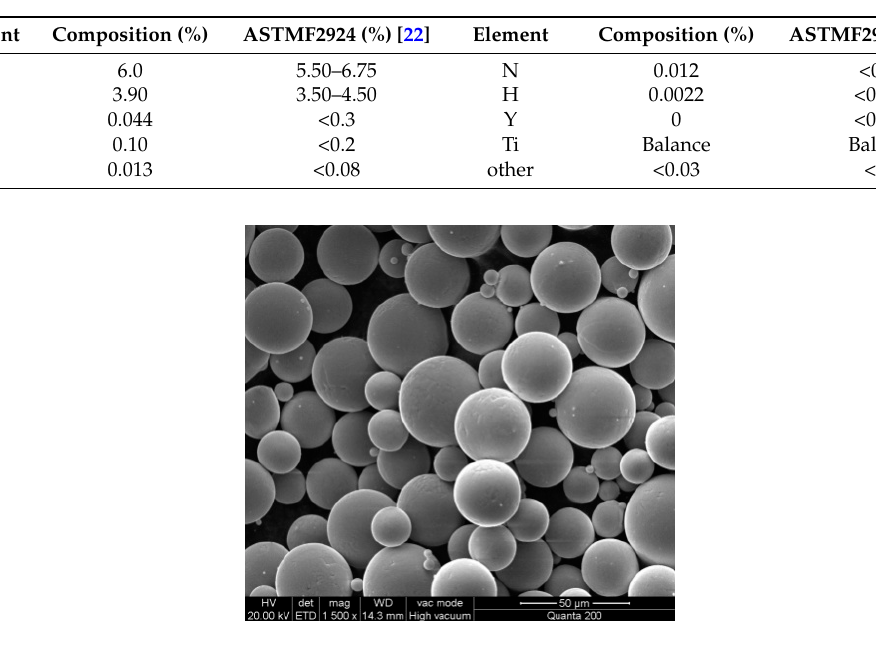
Figure 3. The SEM image of Ti6Al4V powder having the size of 500 mesh.